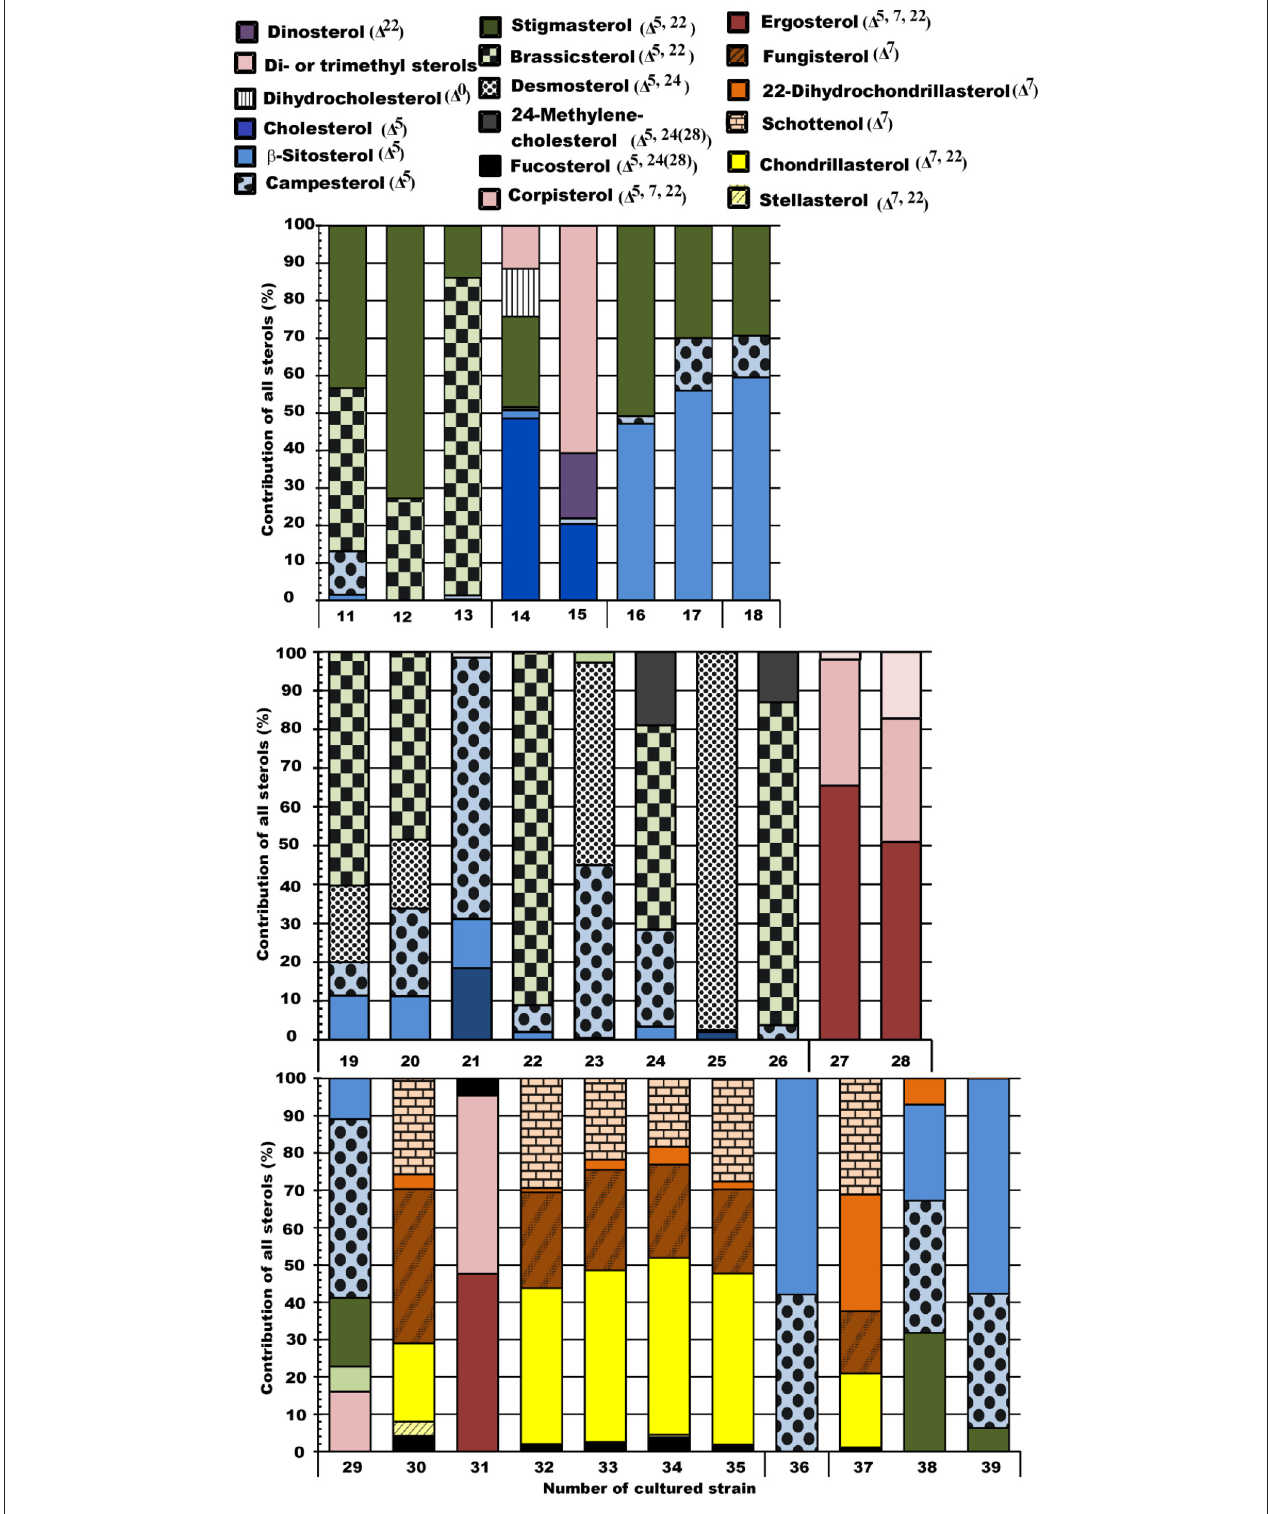
FIGURE 2 | Sterol profiles of the studied phytoplankton strains. Orange-brown represents 1 7 unsaturation, yellow represents 1 7 , 22 diunsaturation, blue represents 1 5 unsaturation, green represents 1 5 , 22 diunsaturation, black represents 1 5 , 24(28) diunsaturation, red represents 1 5 , 7 , 22 triunsaturation, and violet represents 4 α -methyl and 23,24 -trimethyl